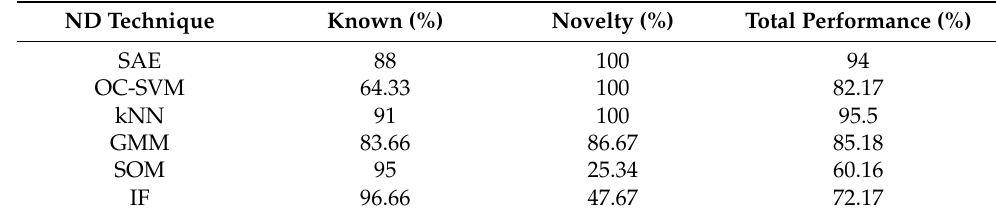
Table 13. Numerical results of the novelty detection obtained for the fourth case study of the WPG_DS.